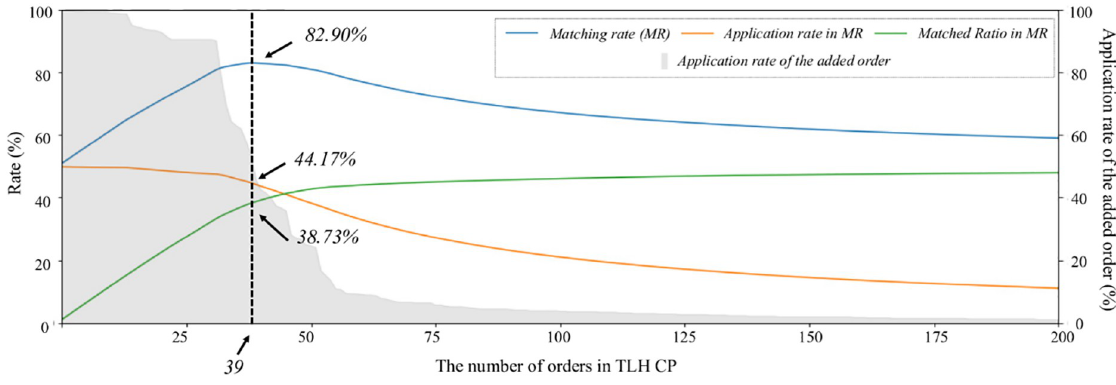
Fig 3. Finding the optimal number of clinical orders in TLH CP.